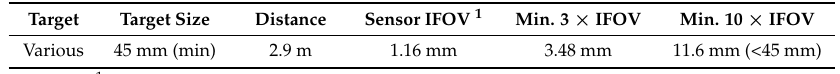
Table 13. Validation sample target distance and IFOV to satisfy minimum target size requirements.